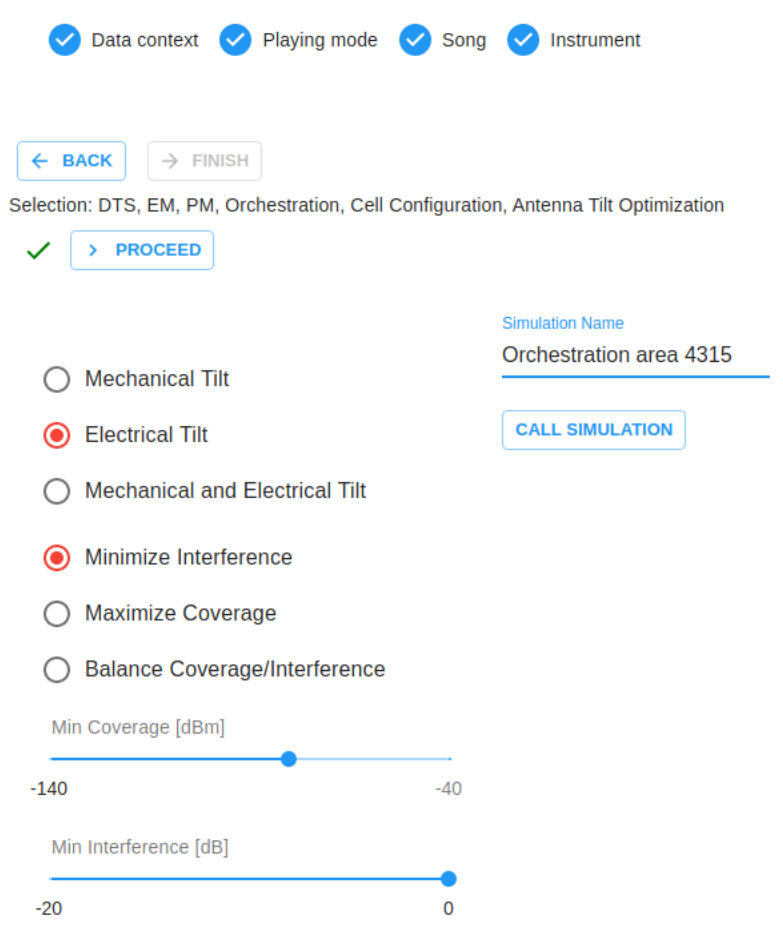
Figure 8. Example of setting inputs and to invoke a RAN